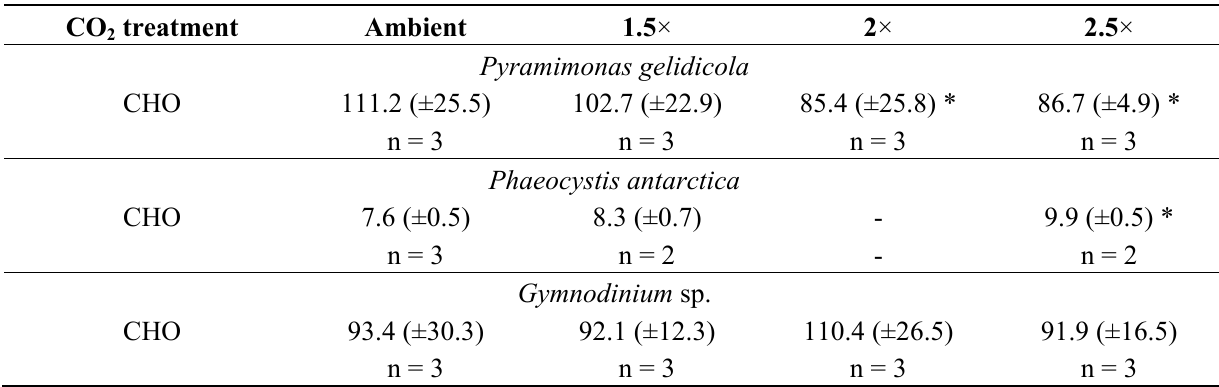
Table 5. Phytoplankton particulate organic carbohydrate (CHO) content in pg cell − 1 of the respective CO treatments. SD in brackets, n = number of samples. * p < 2